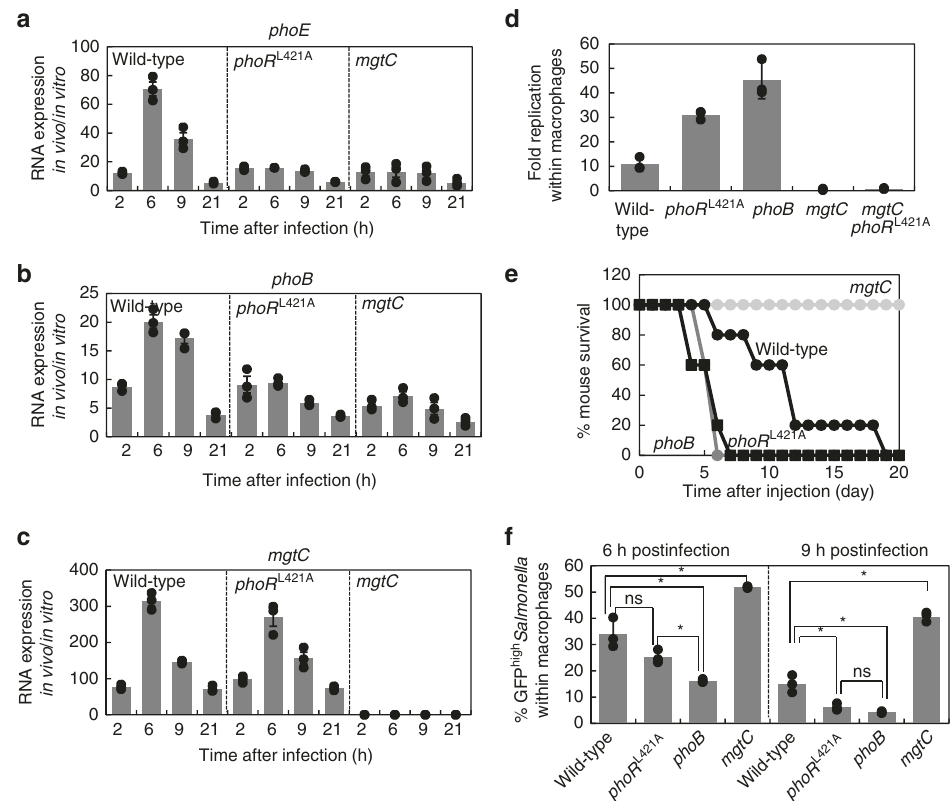
Fig. 5 Leu421 to Ala substitution in PhoR promotes virulence in mice and decreases non-replicating Salmonella inside macrophages. a – c Relative mRNA levels of the phoE ( a ), phoB ( b ), and mgtC ( c ) genes produced by wild-type Salmonella (14028s), the phoR chromosomal mutant with Leu421 replaced by Ala codon (EN949), and an mgtC deletion mutant (EL4) inside J774 A.1 macrophages at the indicated times after infection (mean ± SEM, n = 3 independent infections). d Survival inside J774 A.1 macrophages of the Salmonella strains listed in a – c , the strain deleted for the phoB gene (KK10), and a strain with both the phoR Leu421Ala substitution and mgtC deletion (SM085) at 18 h post infection (T18). Fold replication represents [number of bacteria at T18/number of bacteria at T1]. Shown are the means and SD from three independent infections. e Survival of C3H/HeN mice inoculated